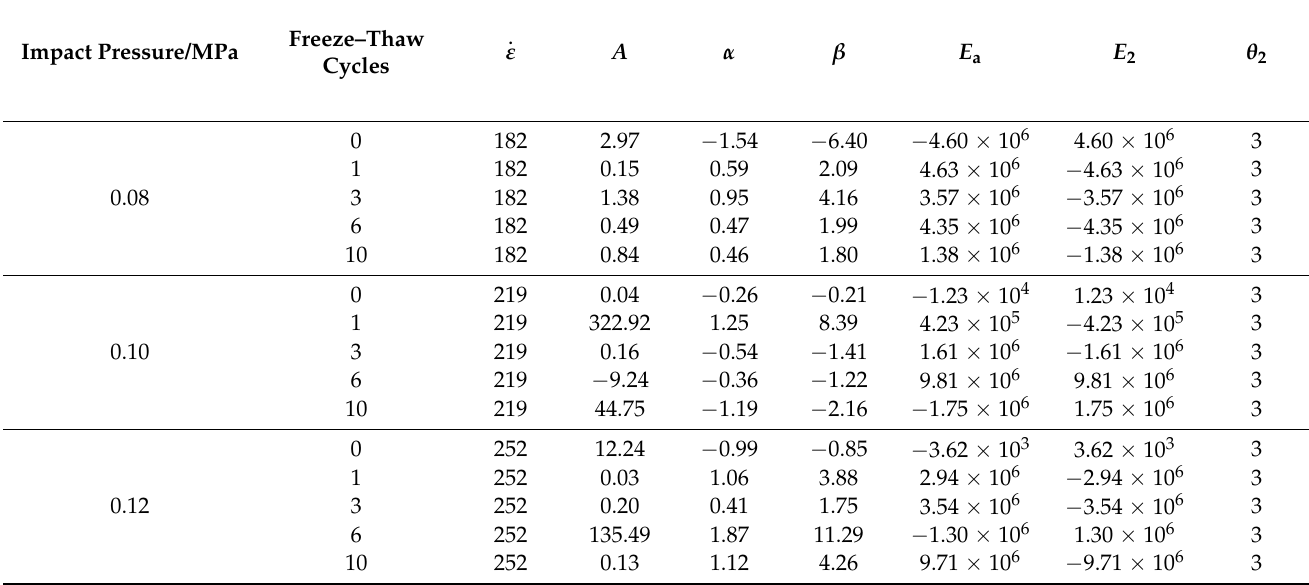
Table 6. Fitting parameters of cement